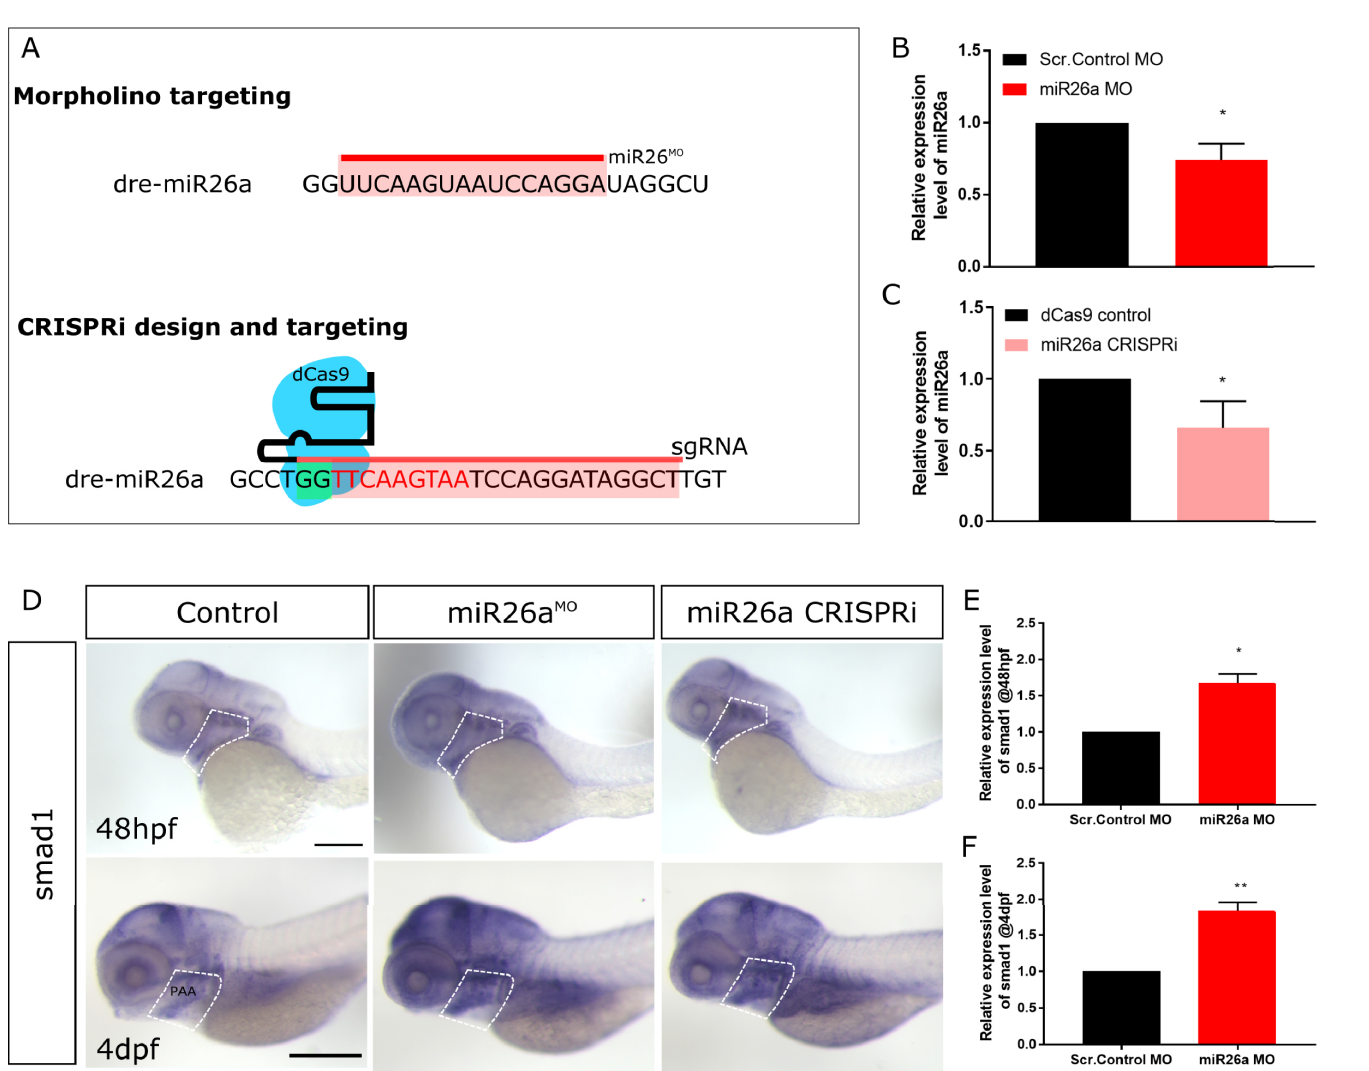
Fig 2. miR26a knockdown increases smad1 expression. A) Schematic of miR26a transient knockdown methods. B and C) Relative expression level of miR26a in morpholino and CRISPRi injected embryos at 48 hpf (n = 3). D) Whole mount in situ hybridization staining for smad1 at 48 hpf and 4 dpf shows increased expression of smad1 in miR26a knockdown embryos particularly in the ventral aorta, aortic arches and pharyngeal region (dotted outline). Scale bar represents 200 μ m. E) Relative expression of smad1 in 48 hpf morphants is increased compared to control embryos (n = 3). F) Relative expression of smad1 in 4 dpf miR26a morphants is increased compared to control embryos (n = 4). RT-qPCR data show the mean ± SEM, Student’s two-tailed t-test � p < 0.05, n = number of biological replicates.